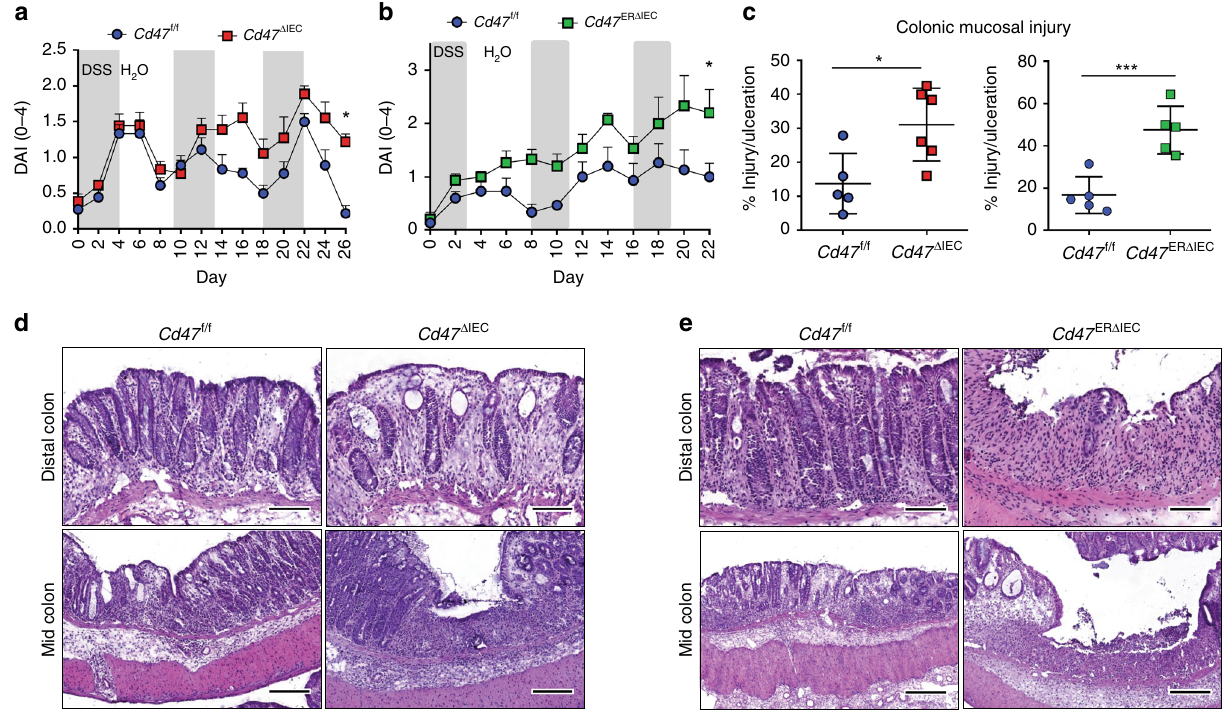
Fig. 4 Loss of CD47 in IEC results in impaired recovery from DSS-induced colitis. Age- and sex-matched Cd47 Δ IEC and tamoxifen-treated Cd47 ER Δ IEC mice were treated with three consecutive cycles of 2.5% DSS in drinking water for either 4 days ( Cd47 Δ IEC ) or 3 days ( Cd47 ER Δ IEC ), followed by 5 days of water recovery. Cd47 ER Δ IEC mice were treated with DSS 2 weeks after tamoxifen treatment. a – b Disease activity index scores are represented as an average of scores 0 – 4 for percent weight loss, stool consistency, and presence of blood in stools. Cyclical treatment of a Cd47 Δ IEC and b tamoxifen-treated Cd47 ER Δ IEC mice with 2.5% DSS in drinking water, followed by a plain water recovery period, induced greater DAI scores in the absence of epithelial CD47. Data are representative of two independent experiments with 5 – 6 mice per group and are expressed as means ± SEM. a * p = 0.02, b * p = 0.036 by two- way ANOVA. c Histological scoring of hematoxylin and eosin (H&E)-stained tissue sections of colonic mucosa: percentage of injury/ulceration represents a ratio of the length of injured/ulcerated areas ( ≥ 50% crypt loss) relative to the entire colon length, as assessed in Swiss roll mounts of the entire colon. Results indicate greater damage in the absence of epithelial CD47. Points represent individual mice. Data are representative of two independent experiments with 5 – 6 mice per group and are expressed as means ± SEM. Signi fi cance determined by two-tailed Student ’ s t test. * p = 0.016, *** p = 0.001. d , e Representative H&E staining of colon tissue sections after three cycles of DSS/water revealed extensive crypt destruction in distal colon of Cd47 Δ IEC and Cd47 ER Δ IEC mice. Large areas of ulcerated mucosa with granulocytic in fi ltrates were present in the mid colon in Cd47 Δ IEC and Cd47 ER Δ IEC mice, in comparison with littermate controls. Scale bars = 100 μ m upper panels, 300 μ m lower panels. Results are representative of at least two